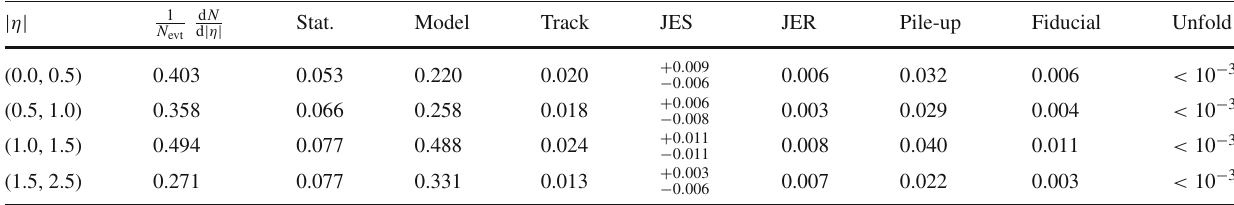
Table 19 Pseudorapidity distribution unfolded to the particle level for the (cid:3) total sample, and including invisible decays, along with the statistical and systematic uncertainties | η